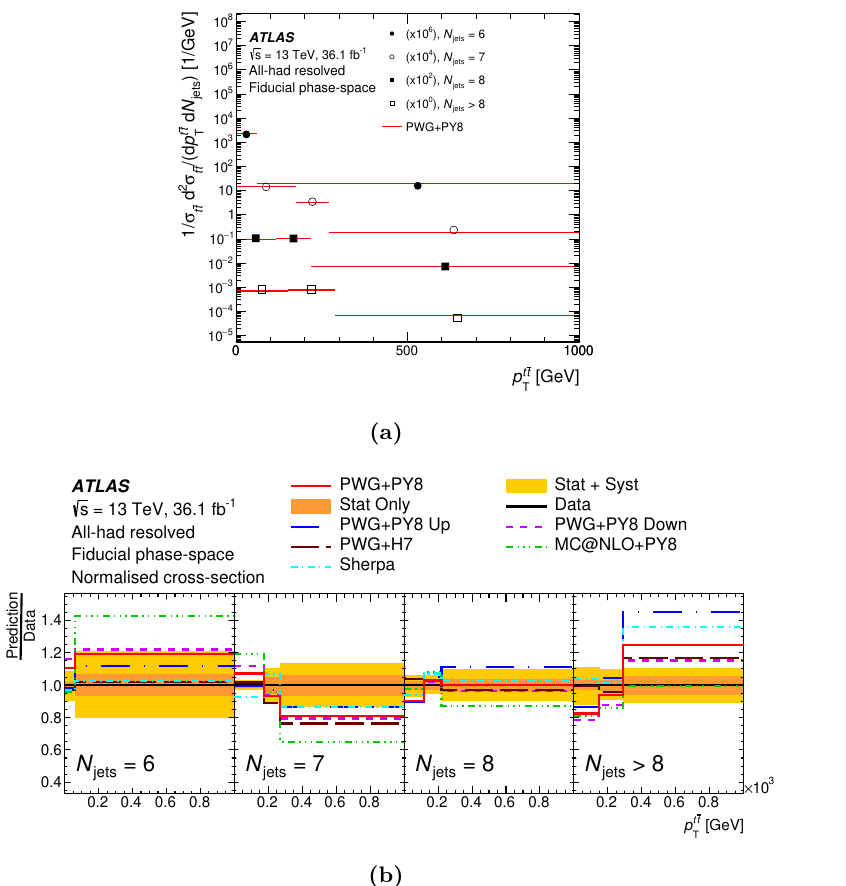
Figure 16 . Particle-level double-differential normalised cross-section (a) as a function of the t ¯ t system transverse momentum p t ¯ t in bins of the jet multiplicity N , compared with the nominal T jets Powheg+Pythia 8 prediction without uncertainties. Data points are placed at the centre of each bin. Different markers are used to distinguish the four bins in N , while p t ¯ t is shown jets T on the horizontal axis. The ratio (b) of the measured cross-section to different MC predictions. Uncertainties are shown by the shaded